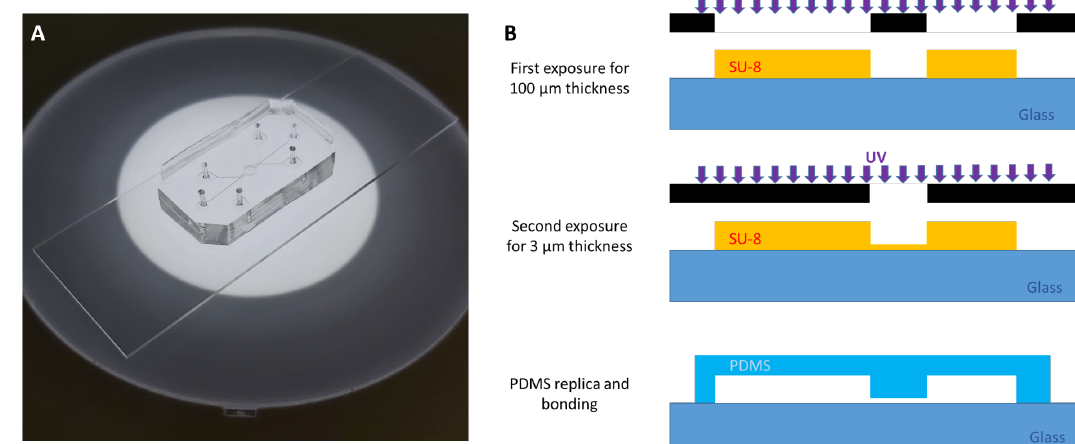
Figure 1. ( A ) Picture of the customised PDMS device. ( B ) Main steps of the photolithography process to realise the mould for the microfluidic device (details in Section